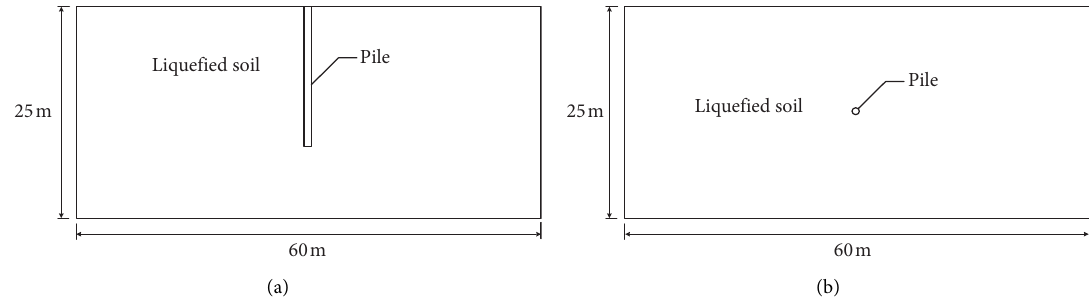
Figure 6: Schematic diagram of the liquefied site. (a) Sectional view. (b) Vertical view.